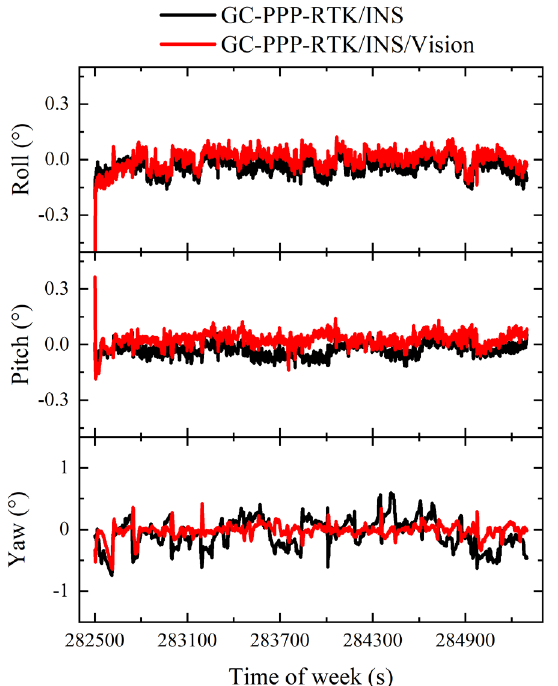
Figure 14. Attitude error series of GC-PPP-RTK/INS and GC-PPP-RTK/INS/vision for T01.